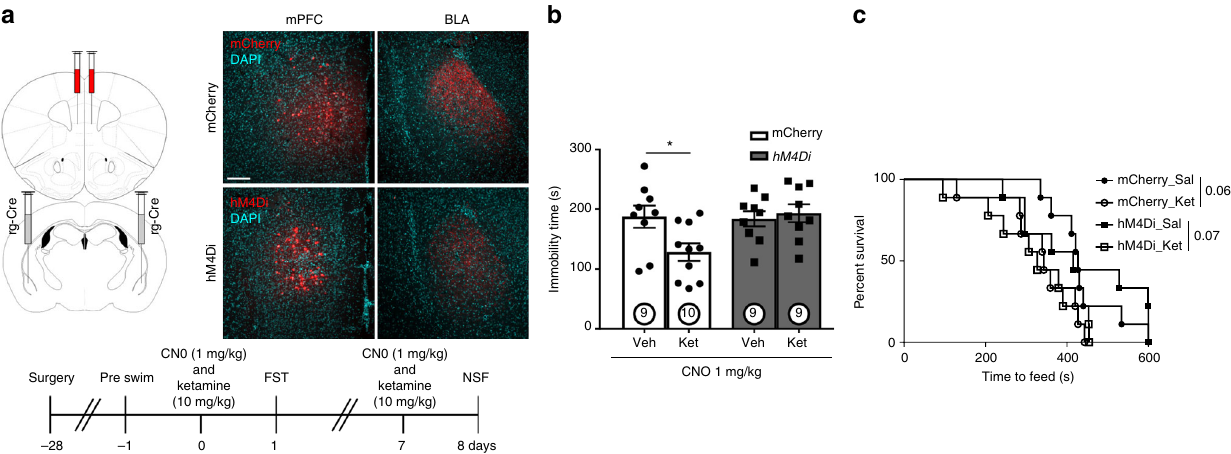
Fig. 6 mPFC projections to the BLA play a role in the ketamine response. a Viral strategy and representative mCherry and hM4Di expression (red = mCherry, hM4D1, cyan = DAPI). b FST immobility time 24 h after CNO and ketamine administration (factoral ANOVA interaction p < 0.05, post-hoc t -test * p < 0.05). c Time to feed in the NSF test 24 h after CNO and ketamine administration (Mantel – Cox (log rank) overall p = 0.06); n = 9 mCherry Veh, hM4Di Veh, hM4Di Ket, n = 10 mCherry Ket. All male. Error bars represent mean ± SEM, scale bar 100 µ